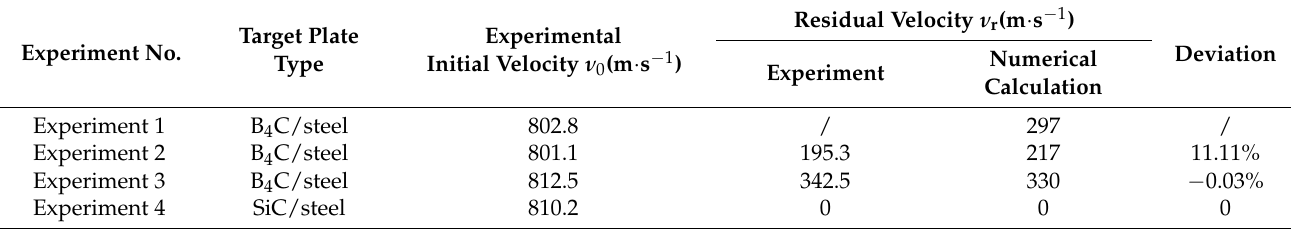
Table 3. Comparison of experimental and numerically calculated residual velocities.